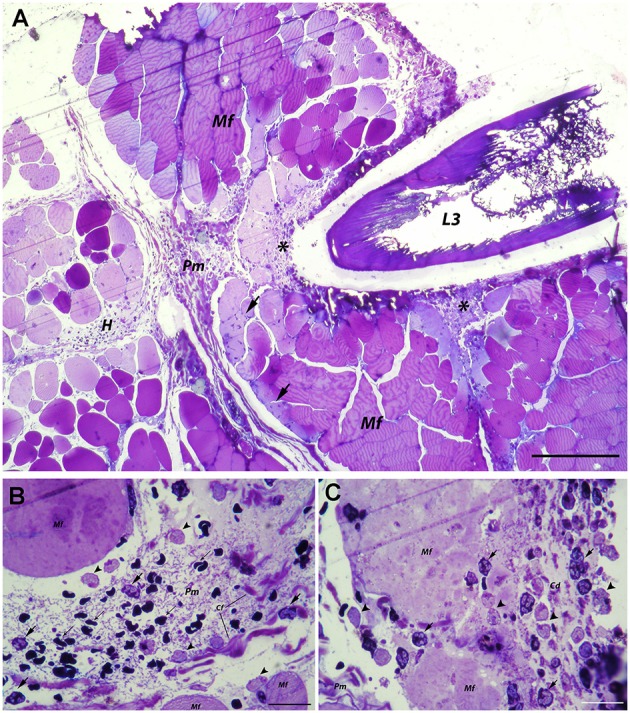
Histopathological findings in abdominal muscle after migration of A. pegreffii L3 larvae. (A) Migration of A. pegreffii L3 larvae through perimysial connective tissue causing tissue necrosis and structural disintegration of muscle fibers (Mf) along the migration path. Large areas of cellular debris mixed with abundant inflammatory infiltrate (asterisks) can be seen. Moderate hemorrhage (H) in perimysium (Pm) together with moderate inflammatory infiltrate can be seen in close proximity to the larva. Occasional polymorphonuclear leukocytes can be seen in endomysium and migrating over muscle fibers (Mf) toward the site of larval penetration (arrows). Scale bar = 200 μm, (B) High magnification of perimysial hemorrhage (H) with non-nucleated erythrocytes (thin arrows) and inflammatory infiltrate composed mostly of neutrophils (arrows) and scant macrophages (arrowheads) interspersed between connective tissue fibers. (C) High magnification of necrotic area showing the structural disintegration of affected muscle fibers (Mf) and abundant cellular debris (Cd) mixed with numerous neutrophils (arrows) and macrophages (arrowheads) close to the larva in the perimysium (Pm; 1% toluidine blue). Scale bar = 20 μm.